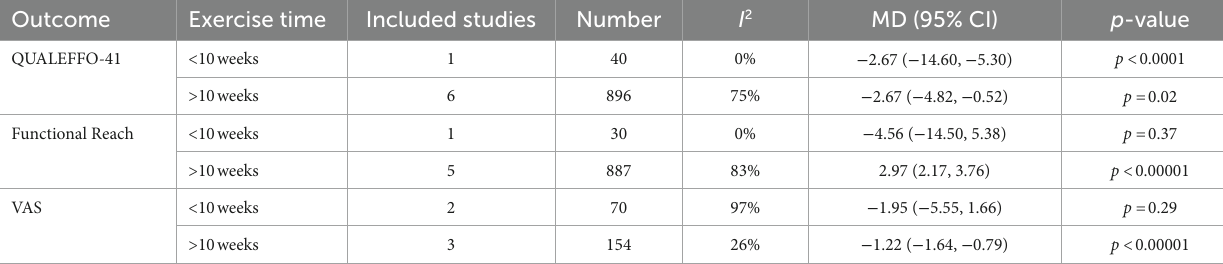
TABLE 3 Subgroup analysis by exercise